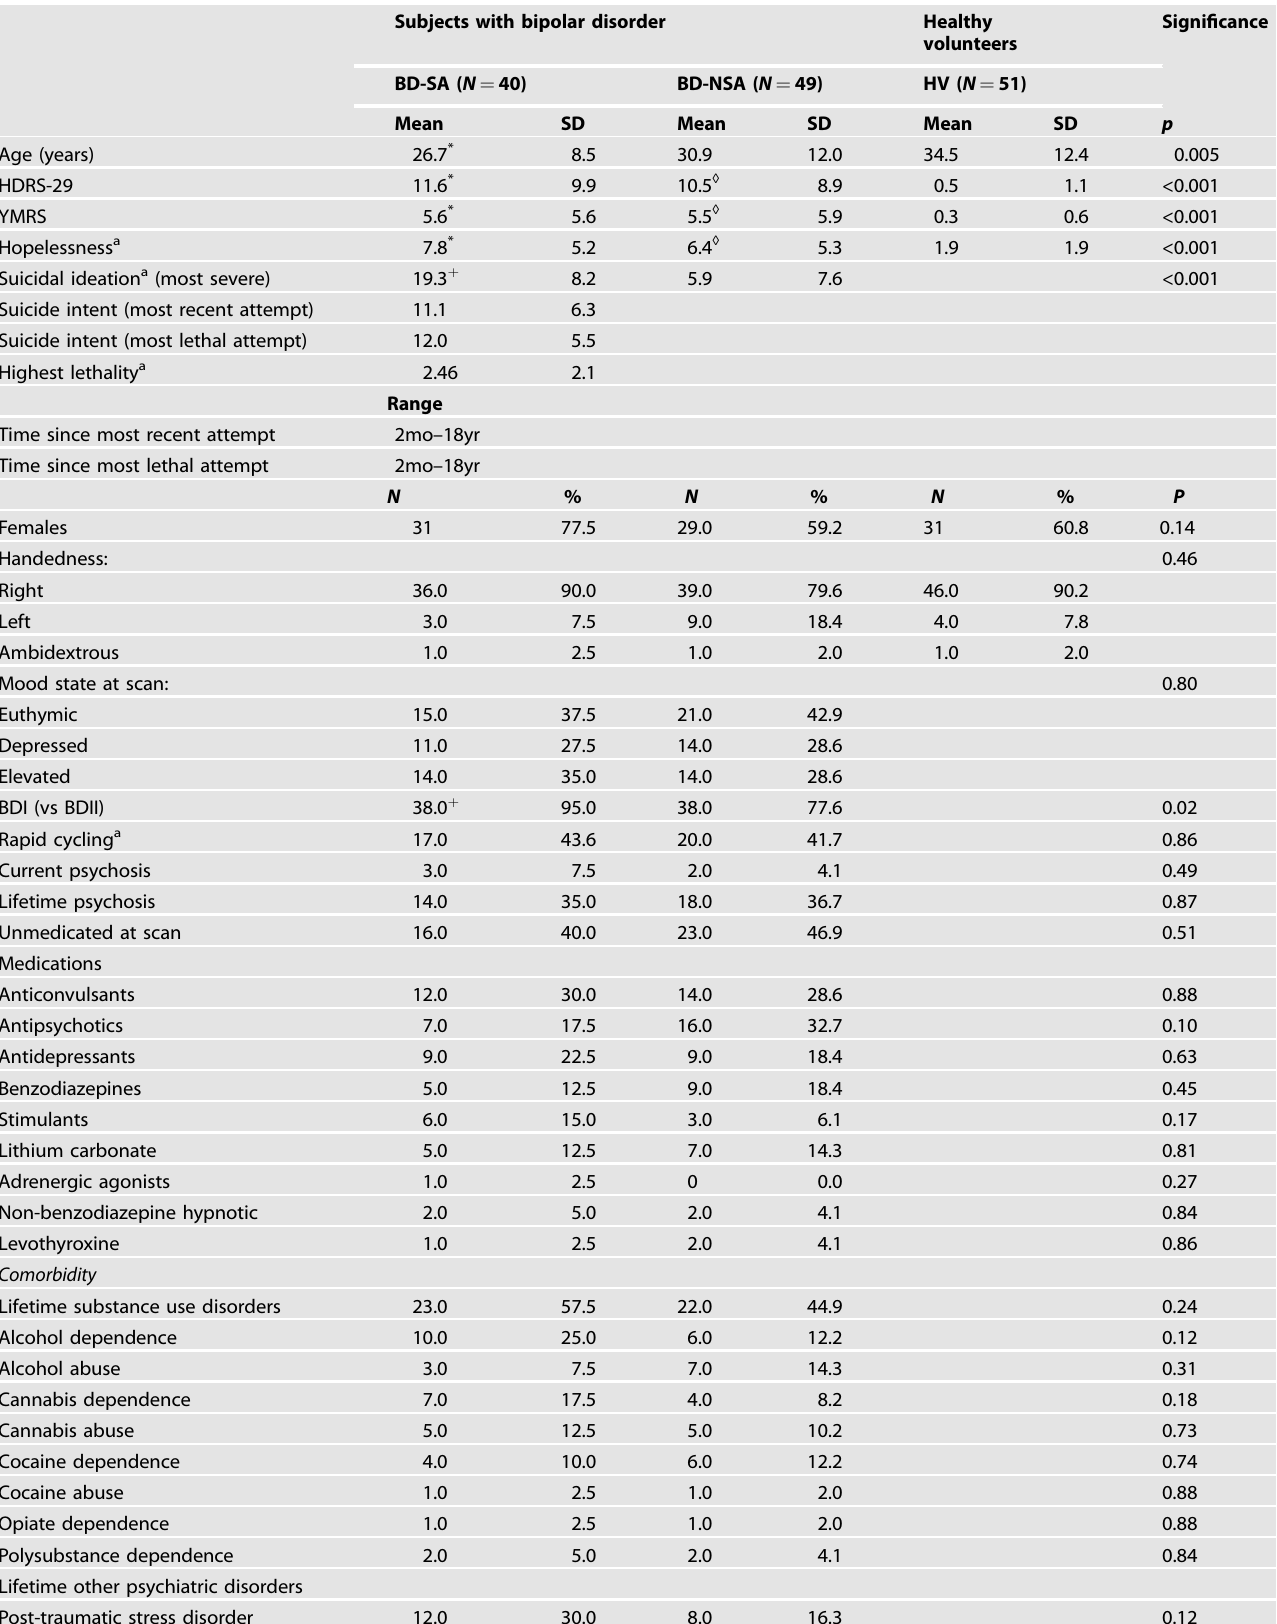
Table 1. Participant demographic and clinical